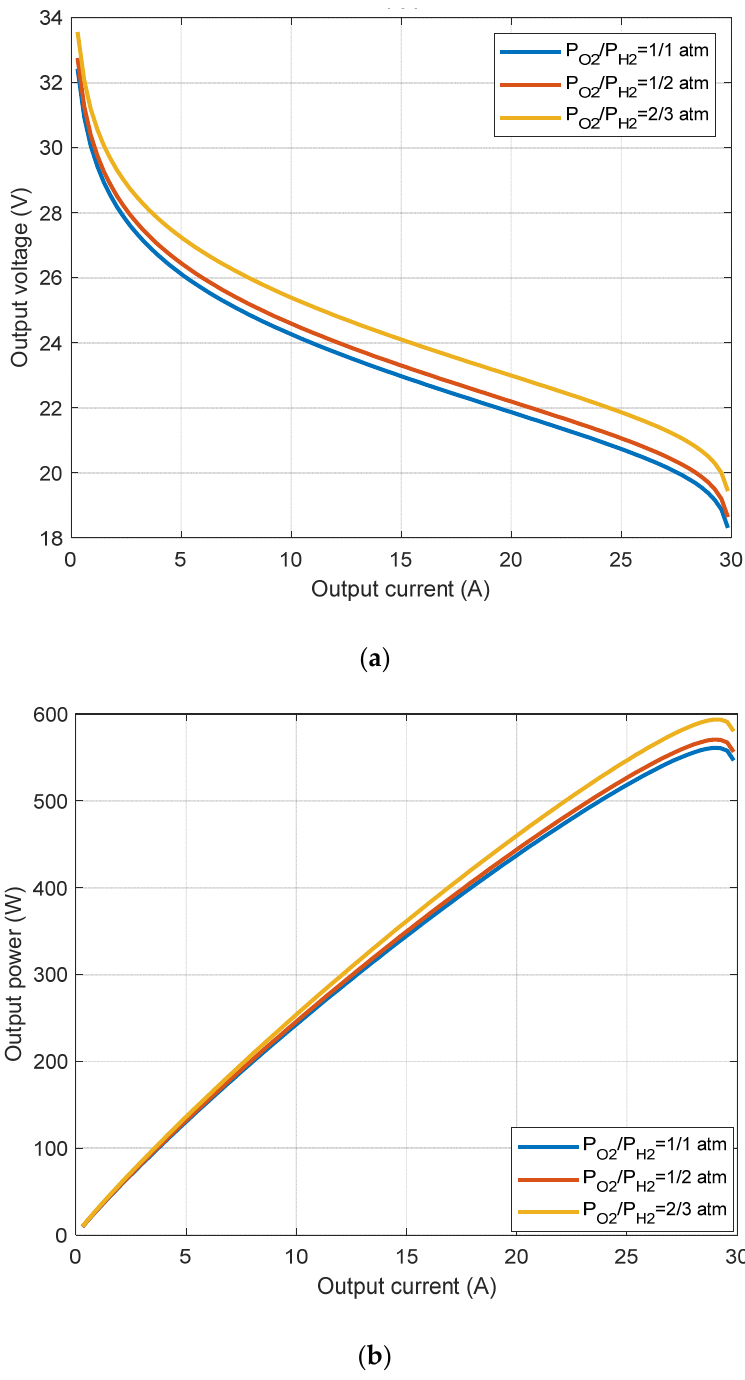
Figure 12. Characteristics of BCS stack under various pressures: ( a ) current-voltage and ( b ) current-power.